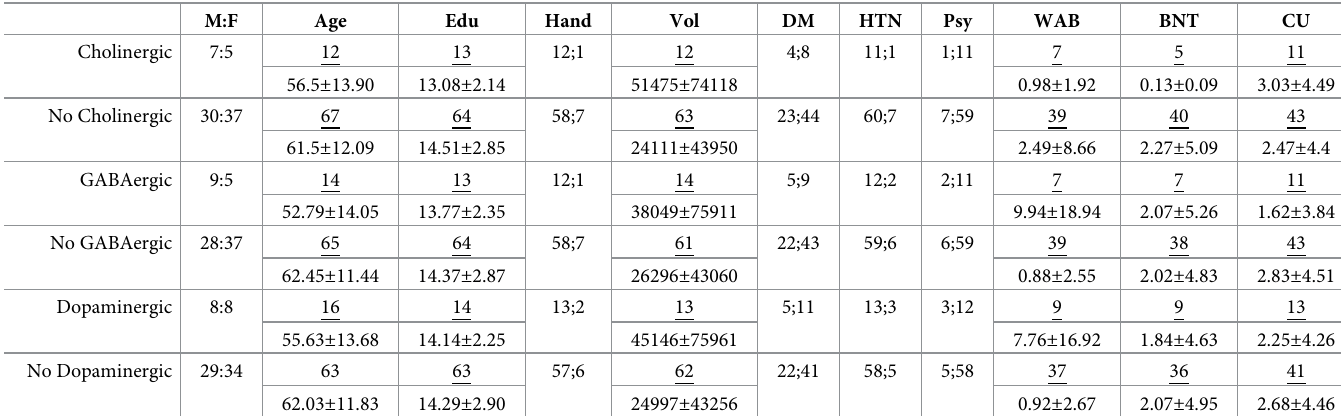
Table 2. Demographic and performance summary by mechanism.